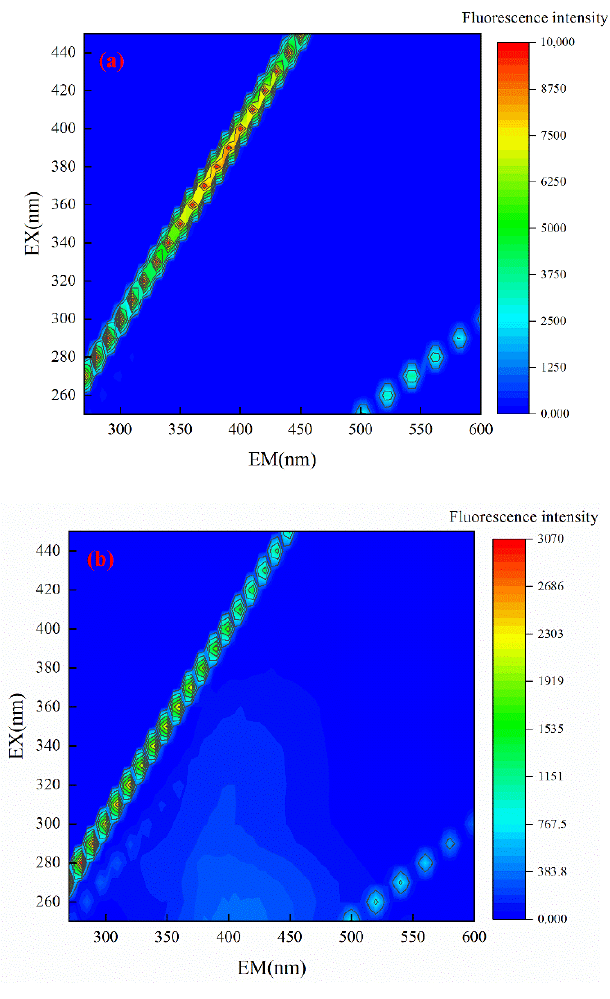
Figure 9. 3D-EEM: ( a ) RO concentrated water, ( b ) effluent after 60 min degradation of RO concen- trated water.